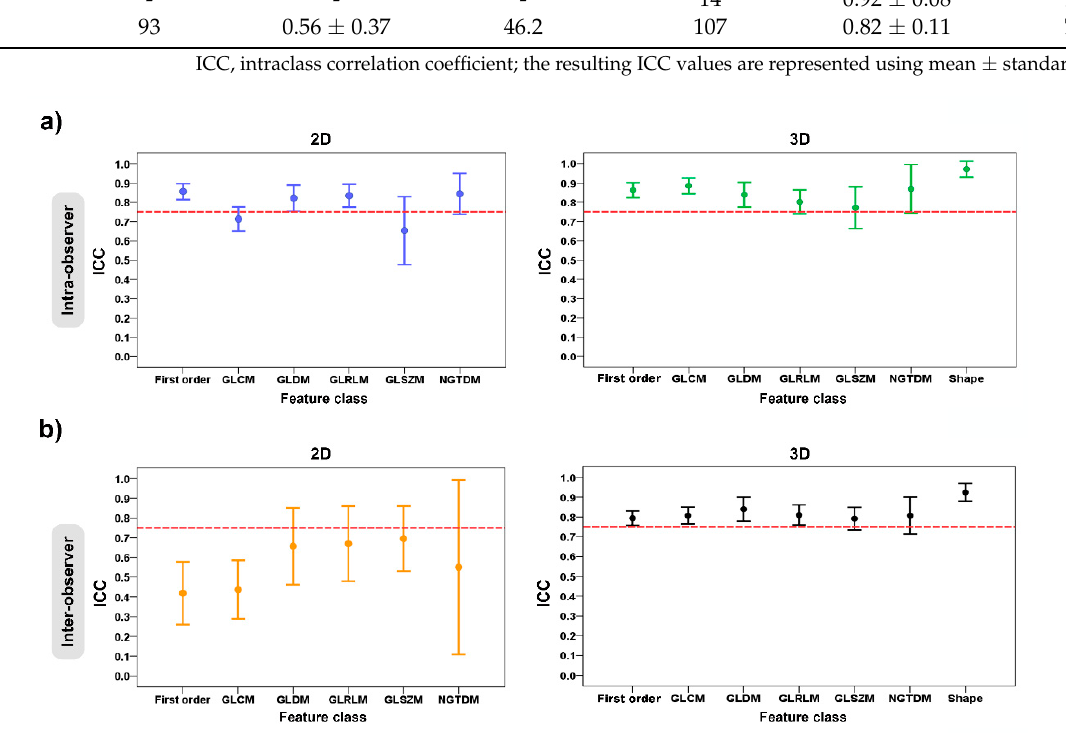
Figure 5. Error plots show the intra- and inter-observer variability of feature classes grouped according to 2D and 3D tumor segmentations: ( a ) intra-observer variability; and ( b ) inter-observer variability. The red dashed horizontal lines denote the intraclass correlation coefficient (ICC) value of 0.75. Table 2. Intra-observer variability of the radiomic-features family and stable feature rate for 2D and 3D tumor segmentations.